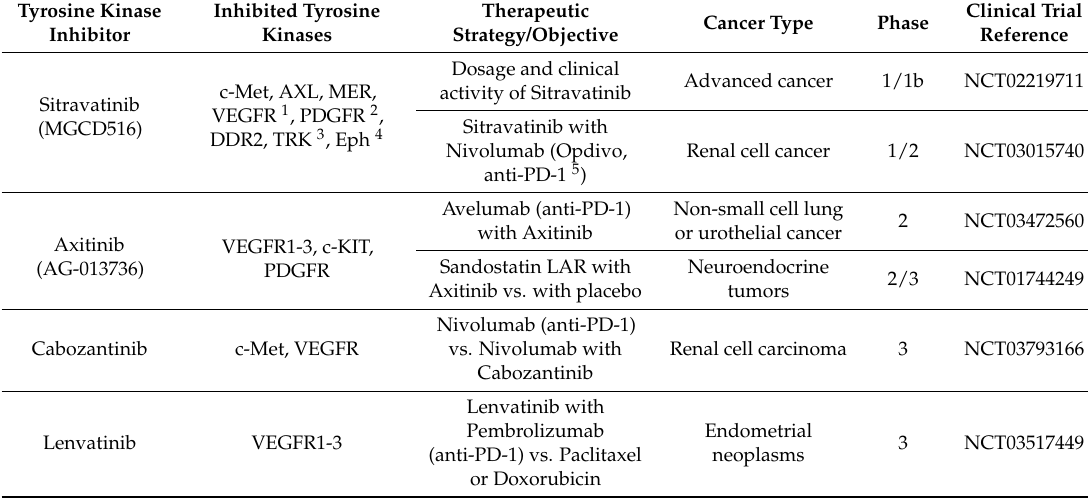
Table 5. Tyrosine kinase inhibitors used alone or in combinatorial therapy in interventional clinical trials currently recruiting or not yet recruiting. Data acquired from the U.S. National library of medicine (http://clinicaltrials.gov, accessed on 16 January 2019). Tyrosine Kinase Inhibited Tyrosine Therapeutic Inhibitor Kinases